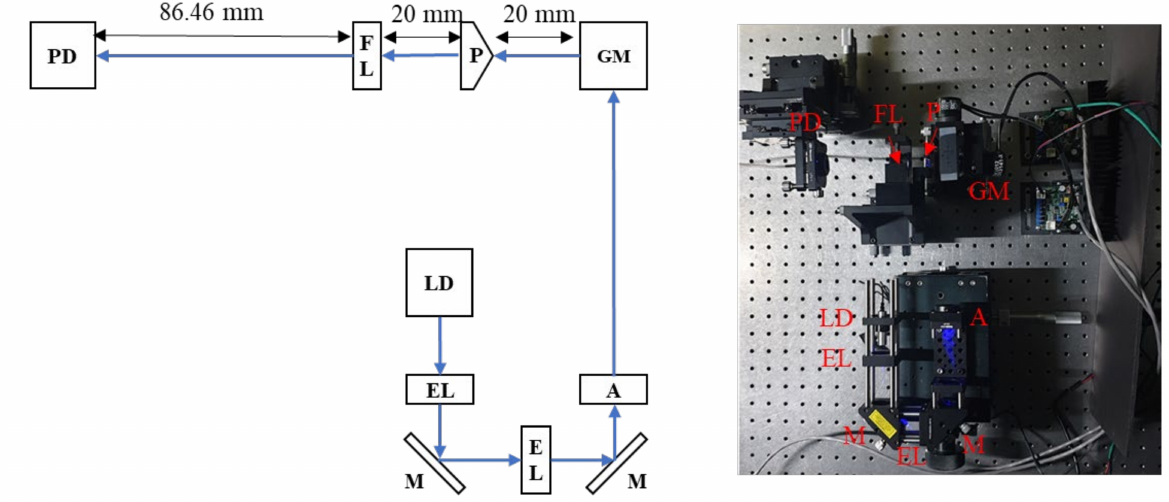
Figure 8. Configuration of laser diode scanner system using galvanometer and its experimental setup. LD—laser diode; EL—expanding lens; M—mirror; A—aperture; GM—galvanometer; P—prism; FL—focusing lens; PD—photo